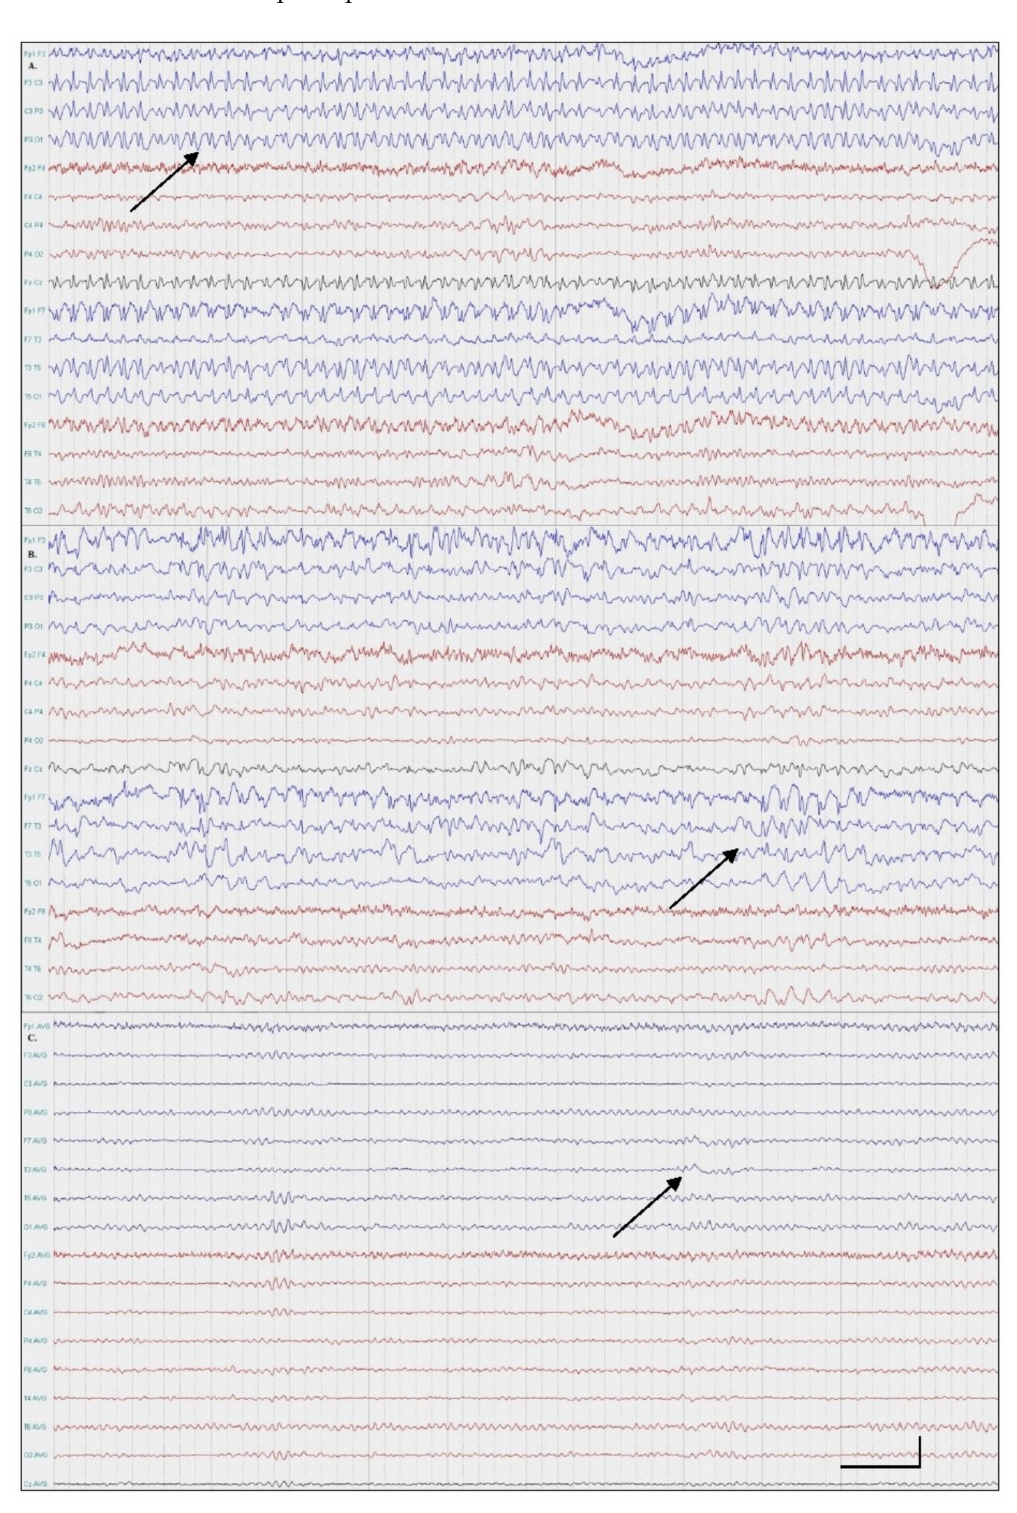
Figure 1. EEGs: Patient One. ( A ) Continuous spike-wave activity over the left hemisphere (maximum over frontotemporal areas); ( B ) very frequent spike-wave activity (double banana montage, 0.3–70 Hz); ( C ) Intermittent theta wave activity over the left frontotemporal region (average monopolar montage, 0.3–70